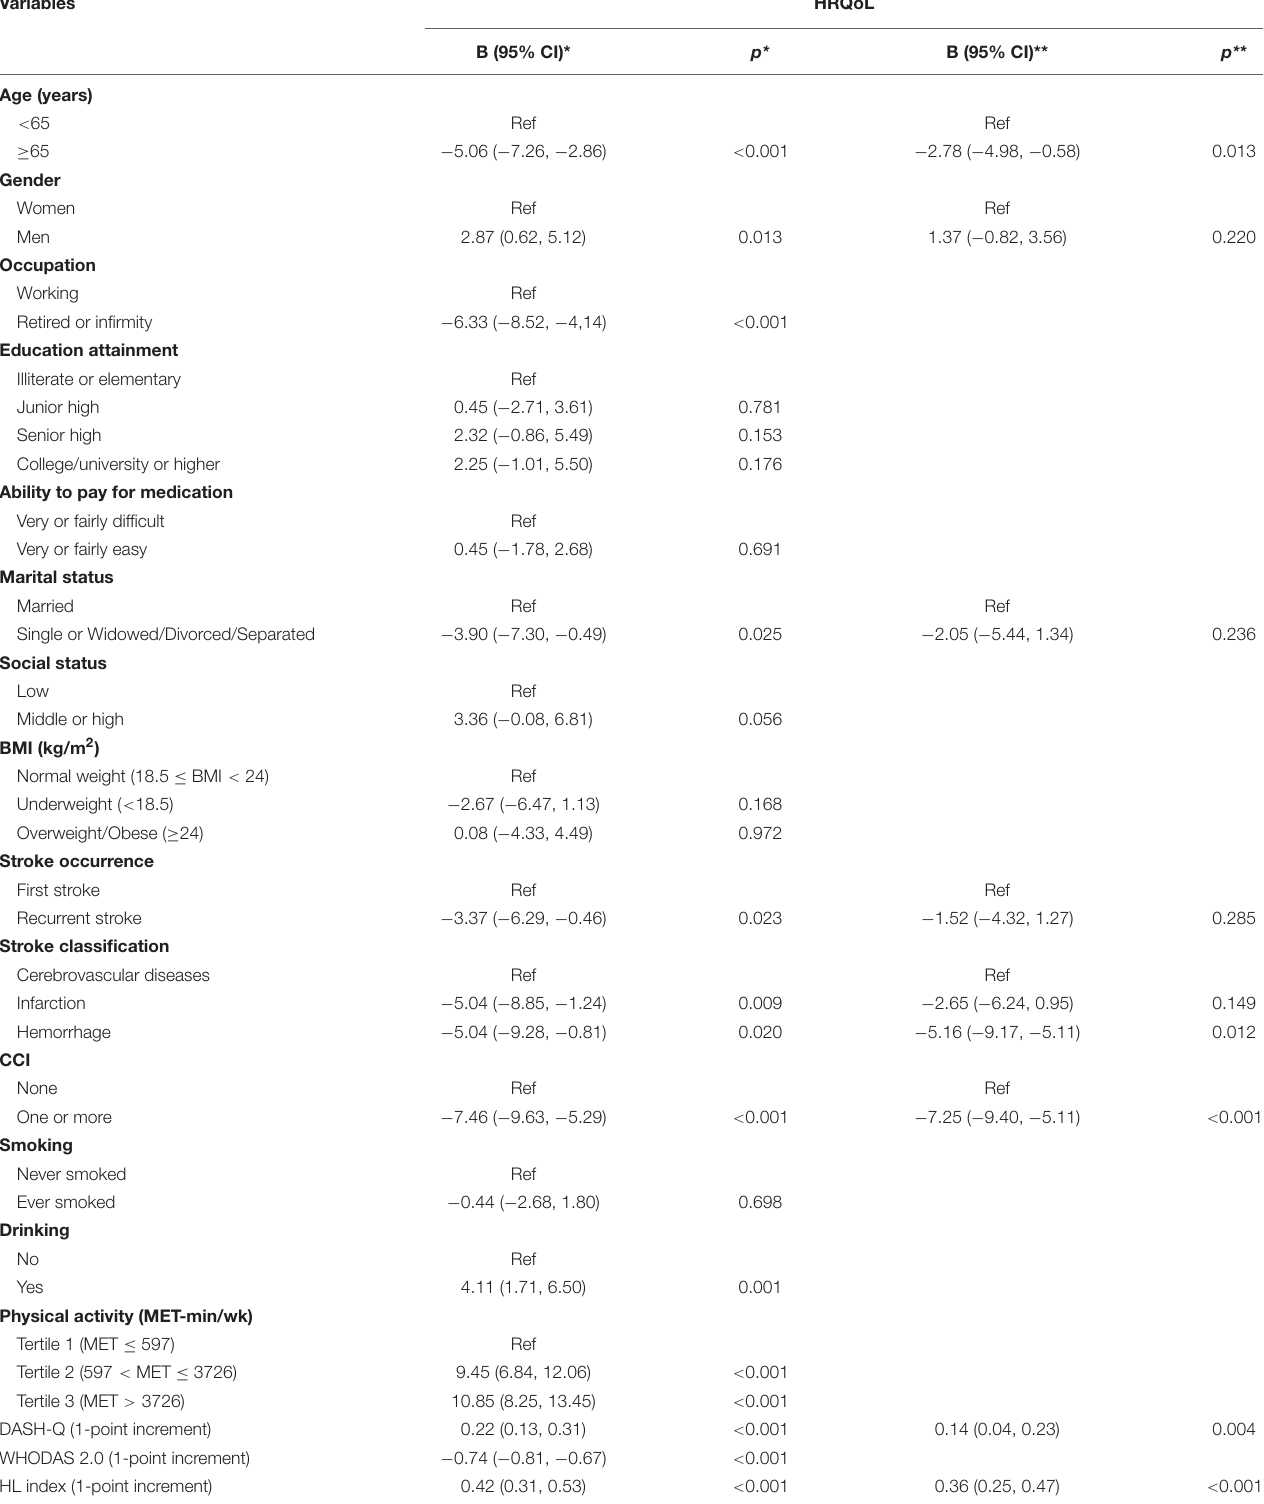
TABLE 2 | Associated factors of HRQoL in patients with stroke ( n =